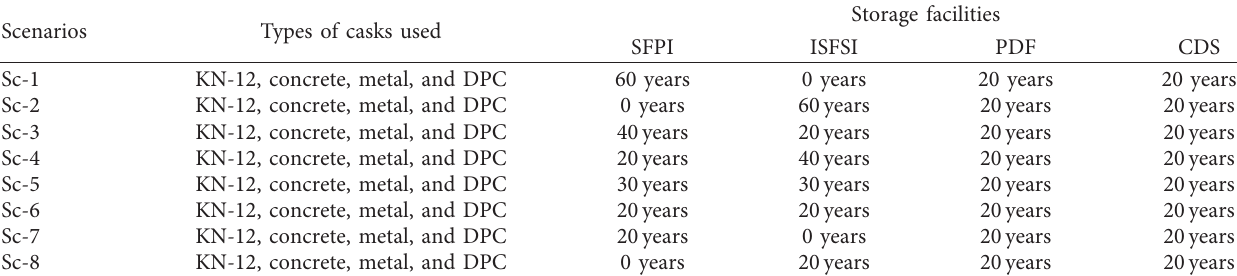
Table 2: Scenario duration assumptions and considerations.